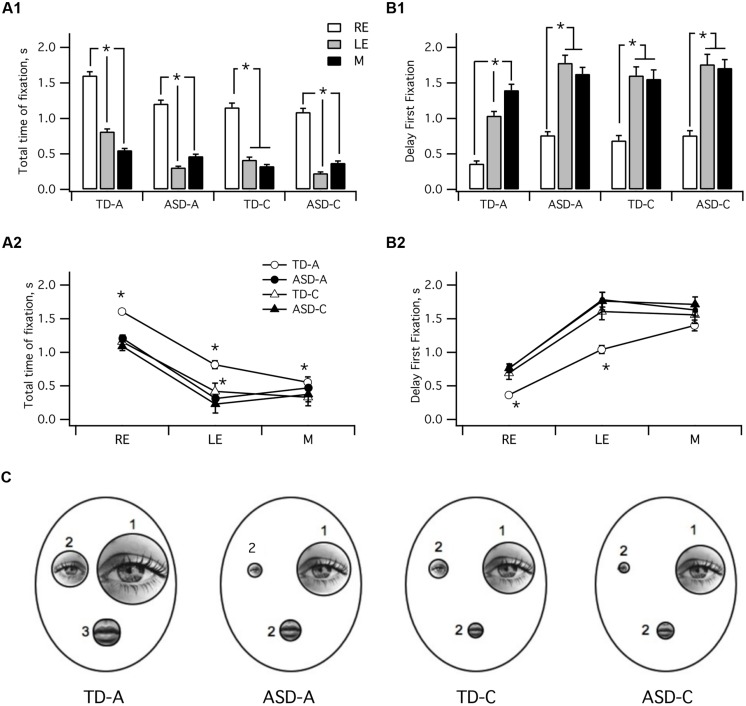
Characteristics of visual fixations in the four groups. (A) mean total time spent on fixation: TD-A (LE > RE > M p < 0.01); TD-C [LE > (M = RE) p < 0.01]; ADL/ASD (LE > M > RE p < 0.01); ASD-C (LE > M > RE p < 0.01). (B) Delay to first fixation in TD-A was shorter than in TD-C or both ADS groups. (C) Summary schematic comparing data for the four groups. The size of each area is proportional to the mean total fixation time and the number beside each area indicates the sequence of fixation. TD-A, typical adult; TD-C, typically developing children; ASD-A, adults with ASD; ASD-C, children with ASD. M, mouth; LE, left eye; RE, right eye. ∗ indicates a significant variation.